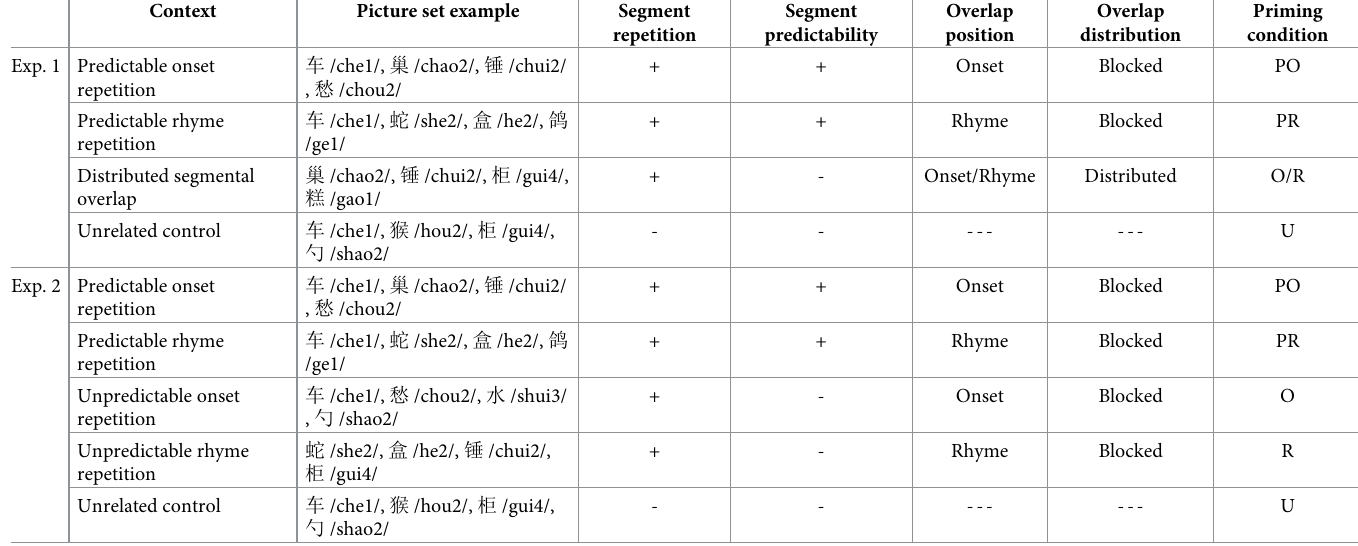
Table 1. Contexts and priming conditions in Experiments 1 and 2. In the context of distributed segmental overlap in Experiment 1, a picture (e.g., 锤 /chui2/ “ ham- mer ”) could be preceded by another picture with onset overlap (e.g., 巢 /chao2/ “ nest ”) or rhyme overlap (e.g., 柜 /gui4/ “ cabinet ”) in their names, so that onset repetition and rhyme repetition were mixed and unpredictable. Trials with immediate onset repetition or rhyme repetition after the preceding trials constituted the priming condi- tion of unpredictable onset repetition (O) or unpredictable rhyme repetition